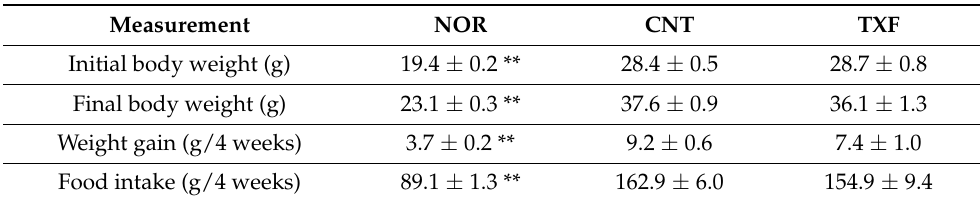
Table 1. Initial and final body weights, body weight gain, and food intake for four weeks in T2D model KK-A y /Ta mice.